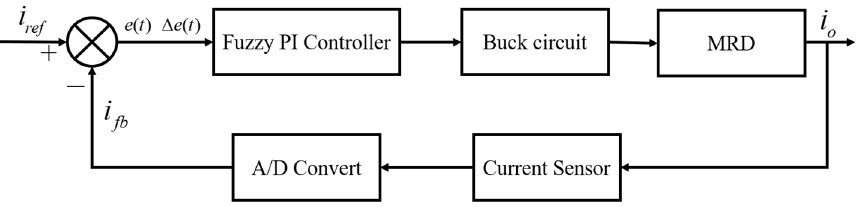
Figure 10. Block diagram of current driver.